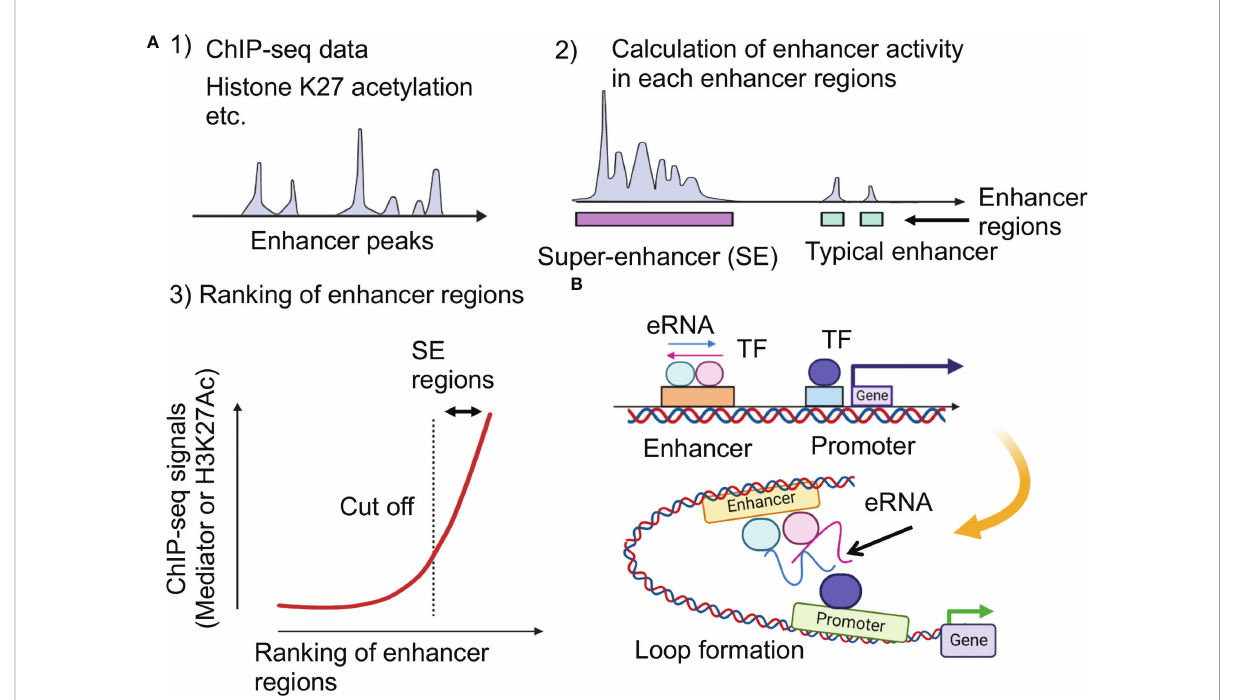
FIGURE 1 Super-enhancer and enhancer RNA (eRNA). (A) Identi fi cation of super-enhancers (16). The higher density of transcriptional regulators through cooperative binding to genomic regions contribute to both activated histone acetylation and higher transcriptional output at super-enhancers. K27: lysine 27. (B) Impacts of enhancer RNAs (eRNAs) at super-enhancers. Highly transcribed eRNAs facilitate formation of loop between promoters and